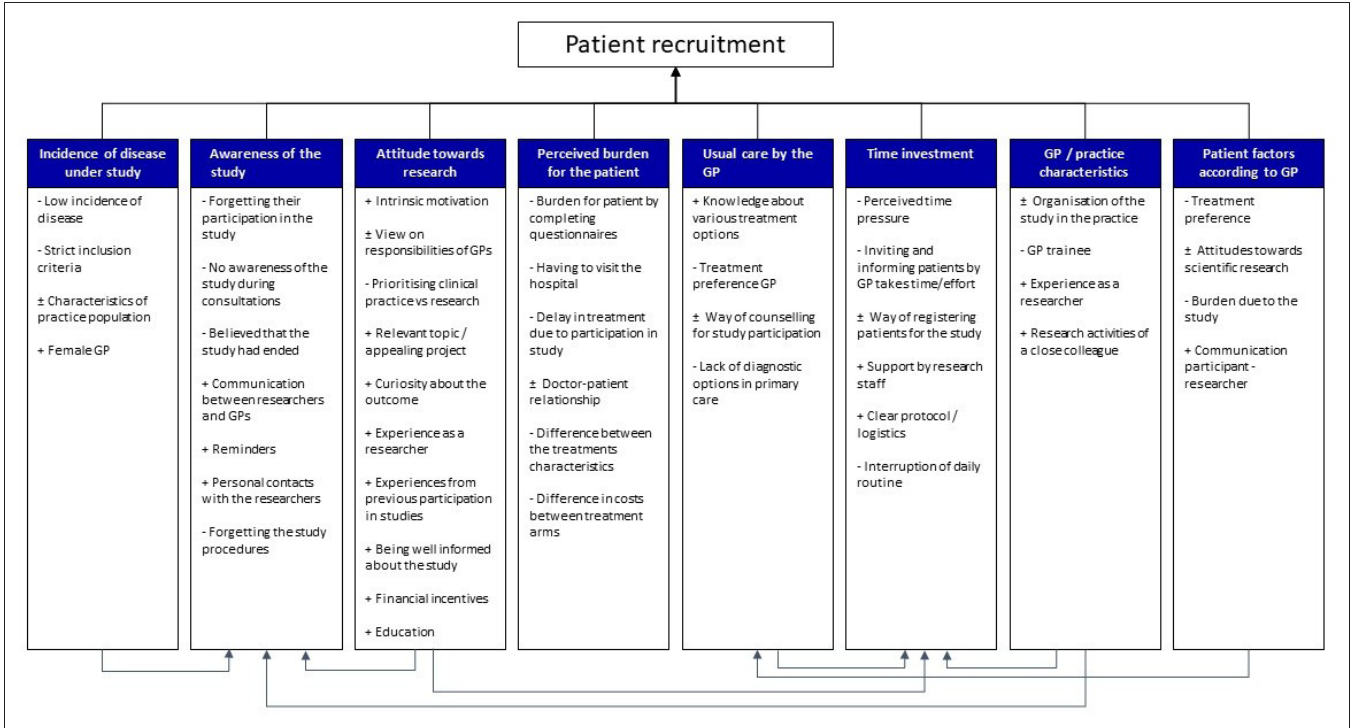
Figure 1 Factors related to patient recruitment for scientific research in general practice. The eight themes and their corresponding factors are shown with an indication as to whether the factor could positively (+) or negatively (-) influence recruitment (± if both were possible). Relevant connections between themes are shown by the ligatures at the base of the